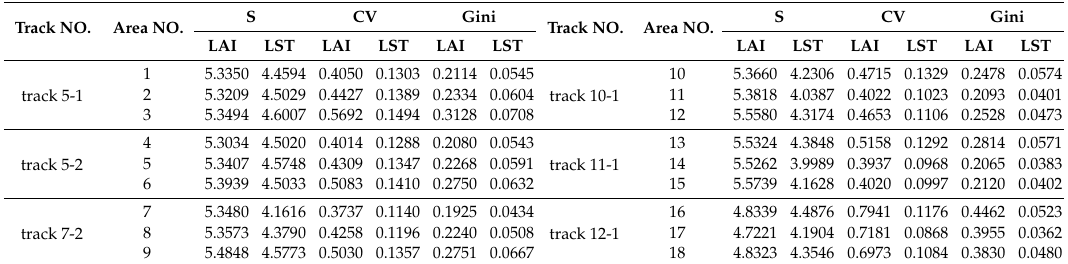
Table 4. Calculation results of the three methods for each variable in different areas. Track NO. Area NO.